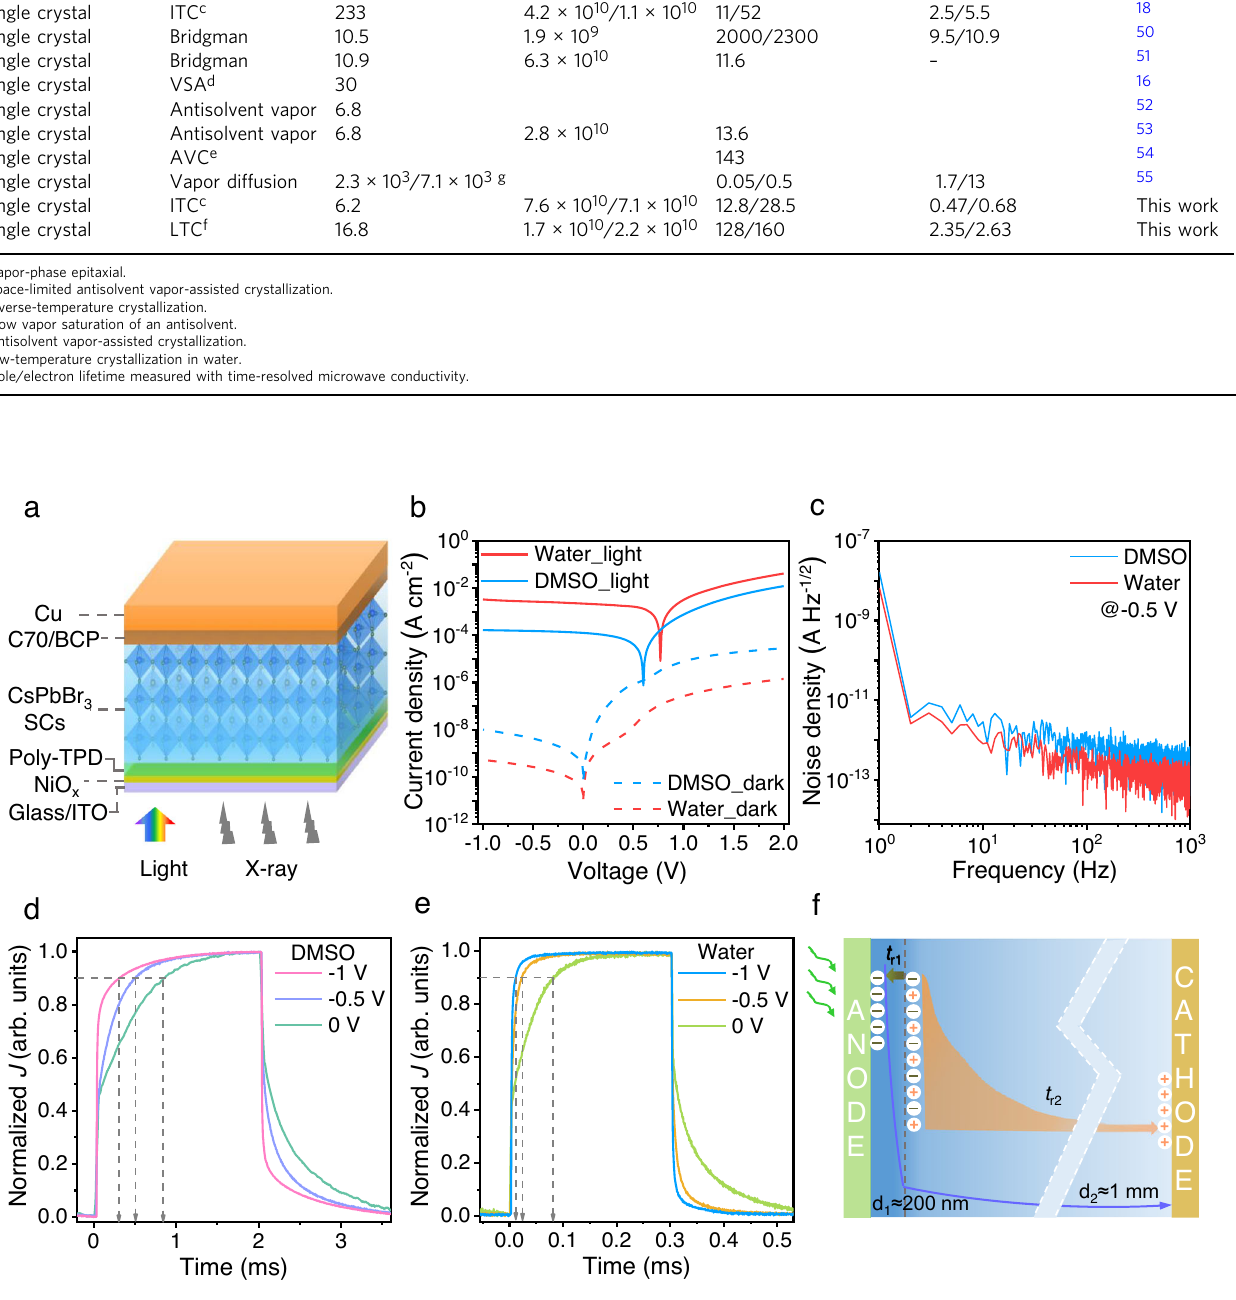
Fig. 4 Device performance of CsPbBr 3 SCs based photodetectors. a Schematic illustration of the device structure of CsPbBr 3 SCs based photodetectors. b J – V curves measured in the dark and under 100 mW cm − 2 white light illumination. c Noise current spectra. Temporal response of the devices based on SCs grown in d DMSO and e water. f Schematic illustration of the surface generation and imbalanced charge transport of the SCs based